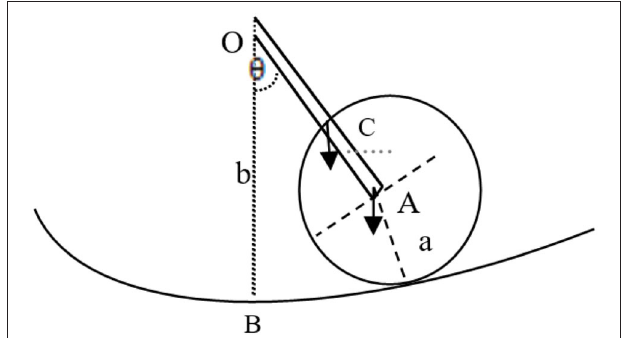
FIGURE 4 | The components of a